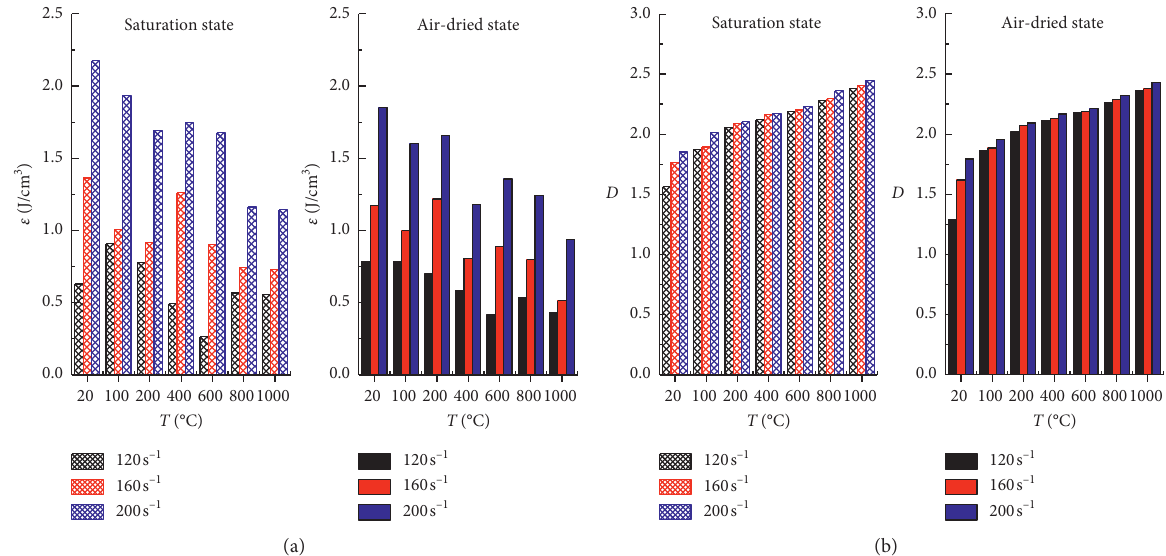
Figure 11: The specific energy absorption and mass fractal dimension of fragmentation of argillaceous sandstone with various temperatures and water content states. (a) Specific energy absorption values. (b) Mass fractal dimension.